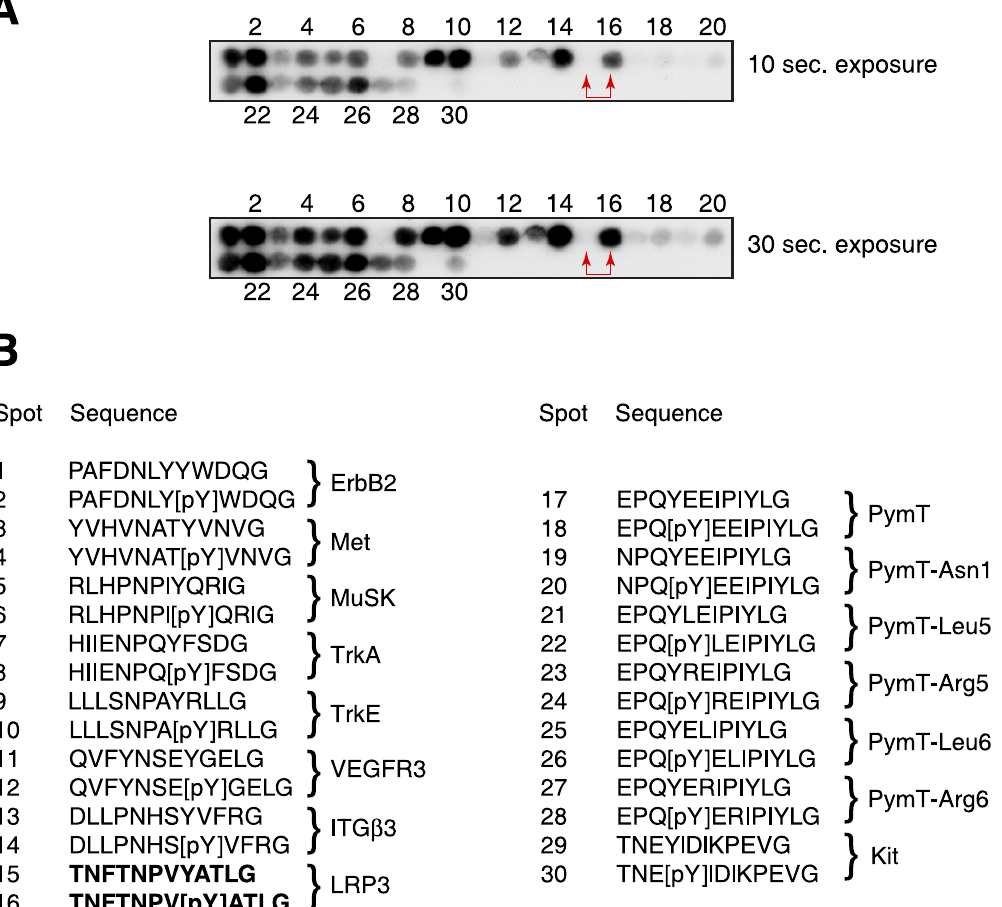
Figure 4. Peptide array experiment. (A) A PepSpots array containing 30 immobilized peptides was probed with purified biotinylated HMTK1 PTB domain. Bound PTB domain was detected using streptavidin-HRP and enhanced chemiluminescence. Exposures from 10 and 30 seconds are shown for dynamic range comparisons. Peptides 15 and 16, selected for further study, are indicated with red arrowheads. (B) Sequences of the immobilized tyrosine- and phosphotyrosine-containing peptides. The proteins from which the peptides are derived are listed to the right of the sequences. Peptides 17–28 contain the polyoma middle T (PymT) sequence (wild-type and single amino acid variants). Peptides 15–16 from LRP3, chosen for further study, are shown in